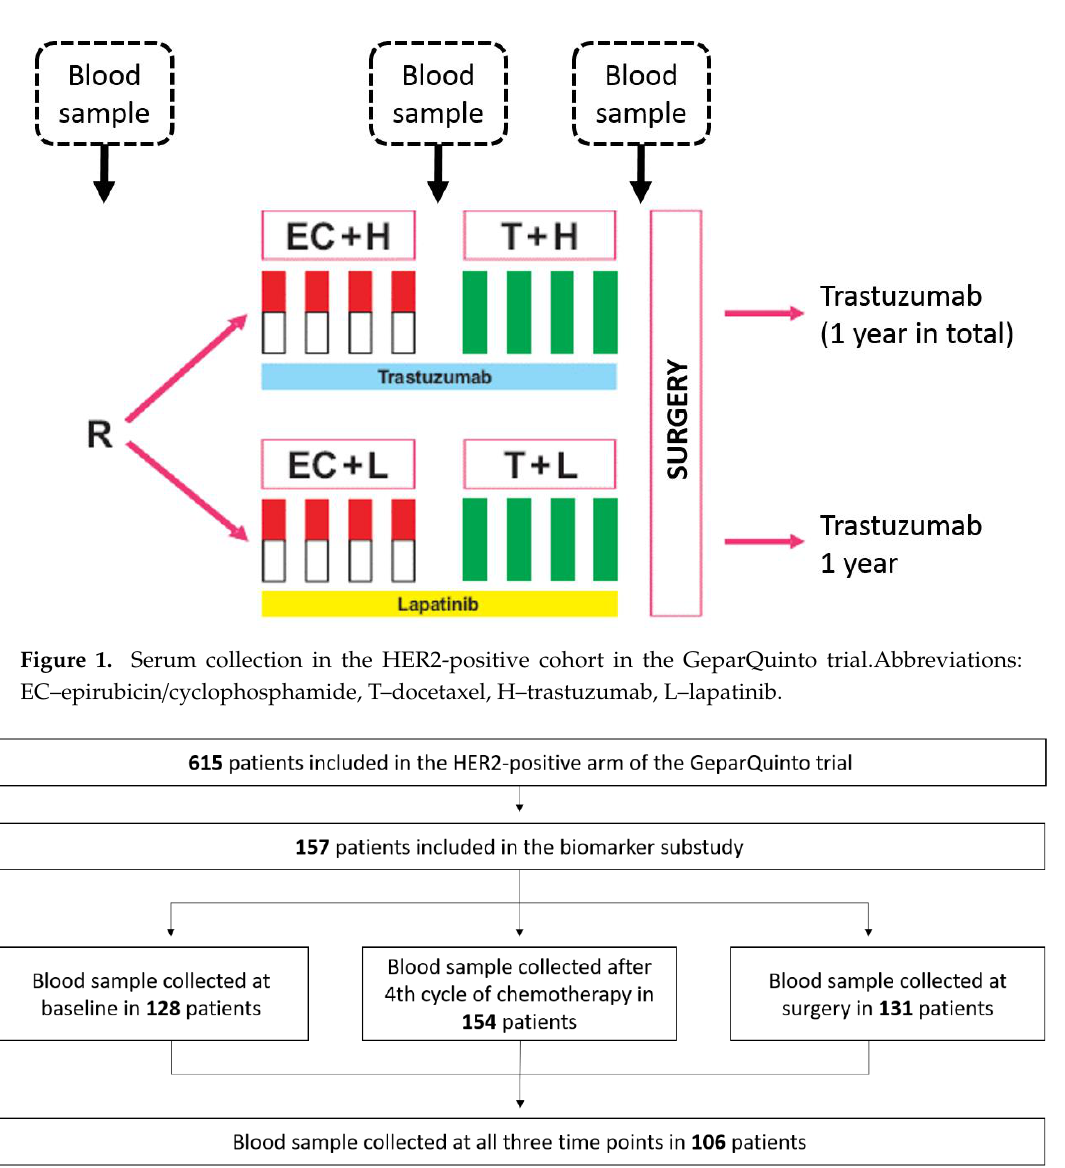
Figure 2. Flow diagram showing the number of patients with a blood sample collected at different time points.